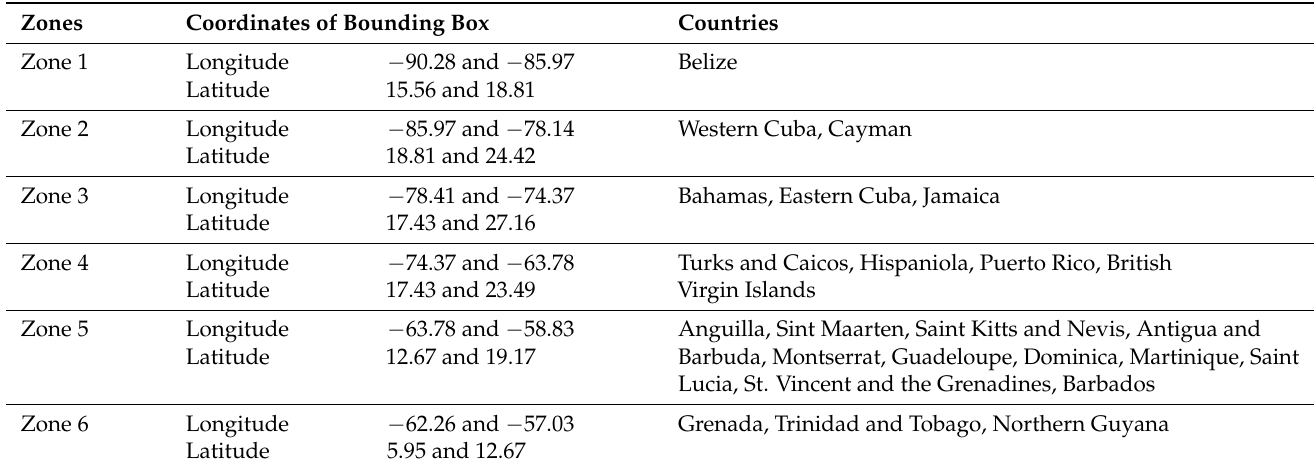
Table 2. Definition of six Caribbean rainfall zones used for regional climate model (RCM) experiments.